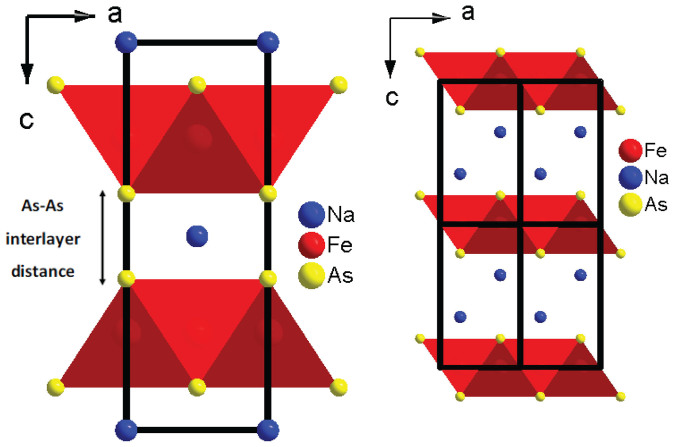
(a) ThCr2Si2-type crystal structure of NaFe2As2,(b) PbClF-type crystal structure of NaFeAs.